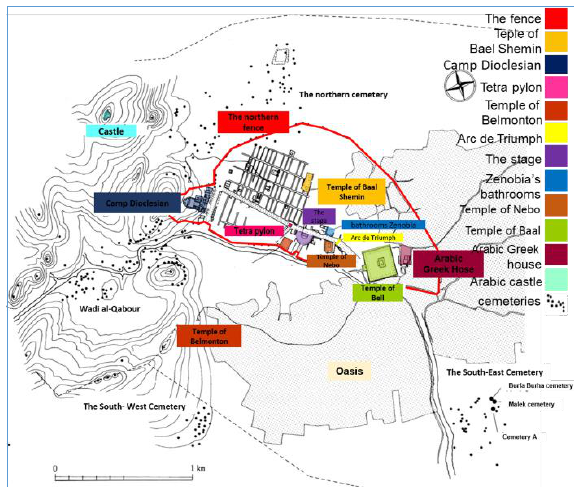
Figure (4) The main monuments in Palmyra’s site